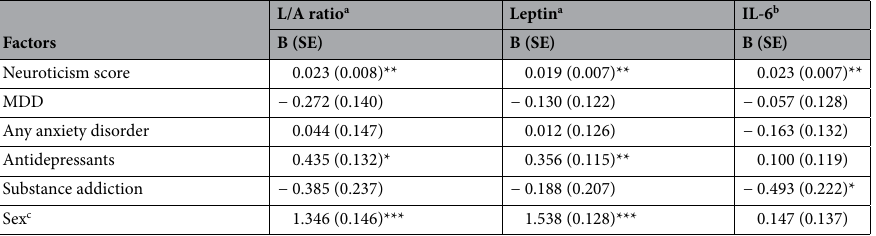
Table 3. Generalized linear models for the L/A ratio, leptin and IL-6 in the total study population (N = 218). L/A leptin/adiponectin, MDD major depressive disorder, SE standard error. *p < 0.05; **p < 0.01; ***p < 0.001. Included: a n = 218; b n = 202; c Reference = Male.